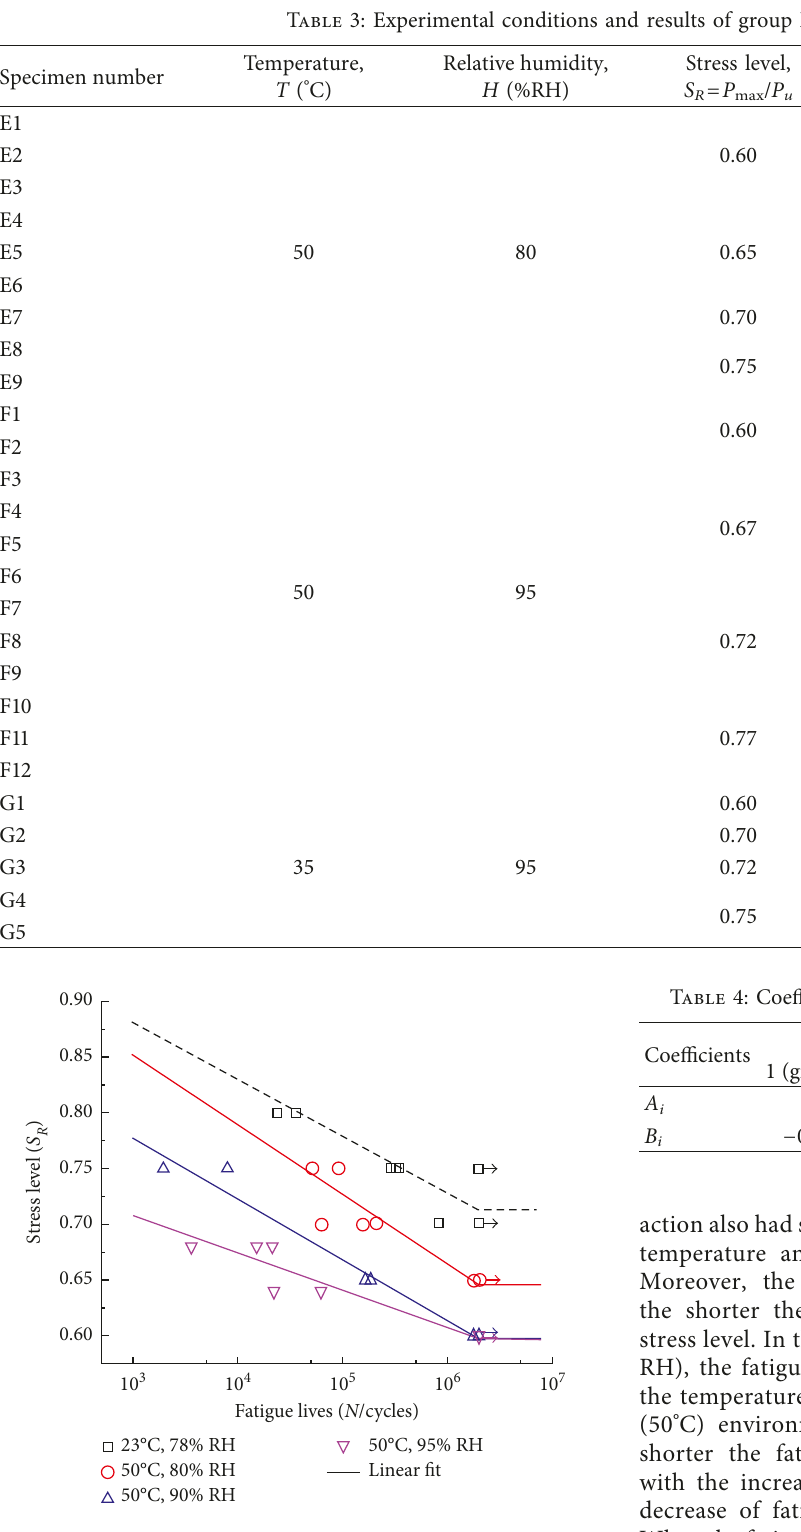
∼ N curves under uncoupling of hot-wet R